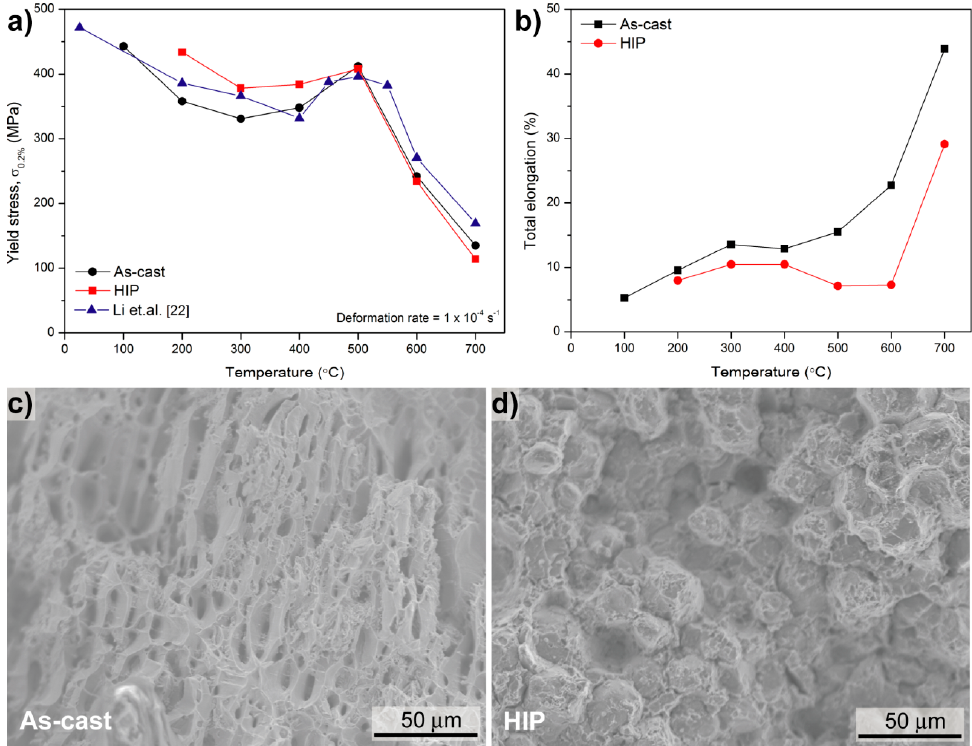
Figure 5. ( a ) Tensile 0.2% yield stress and ( b ) total elongation of as-cast and HIPped Fe-Al-Mo-Ti-B; fracture surfaces of ( c ) as-cast and ( d ) HIPped Fe-Al-Mo-Ti-B at 600 °C. The compressive 0.2% yield stress of Fe-25.5Al-2.1Mo-0.5Ti-1.2B is added in (a) for comparison